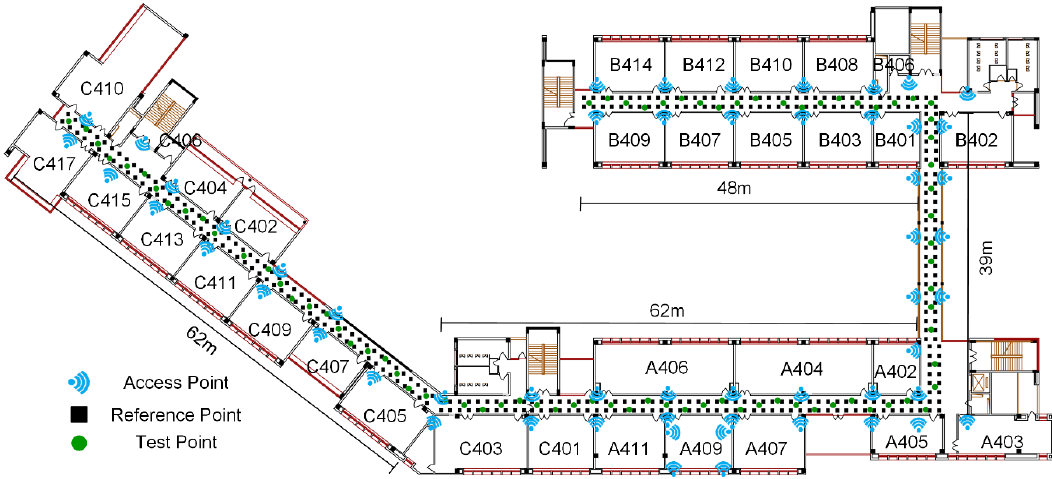
Figure 2. The layout of the experimental testbed, where the blue signal symbol denotes Wi-Fi access point, the black solid rectangle refers to the reference point, and the green solid point is test point.